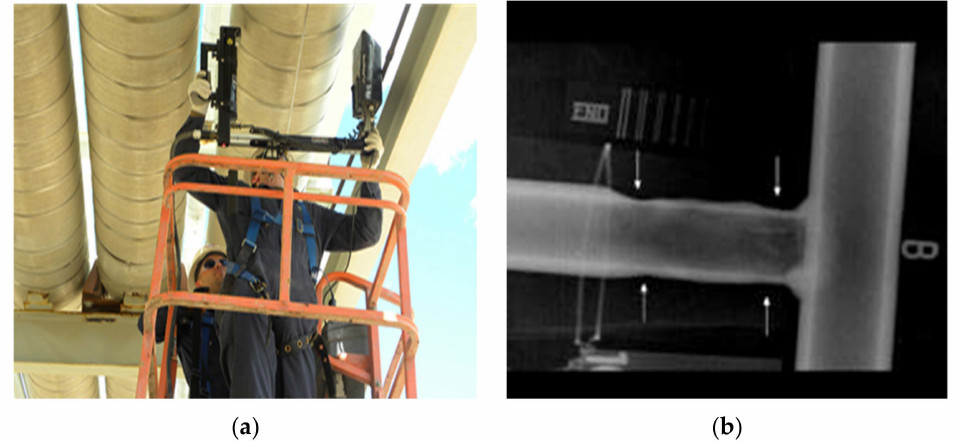
Figure 8. Radiography technique to image the wall thickness loss using C-arm equipment. ( a ) Operator holds the C-arm machine to check potential piping damage; ( b ) Radiography images showing pipe wall thickness loss. Reprinted with authors’ permission from Ref.